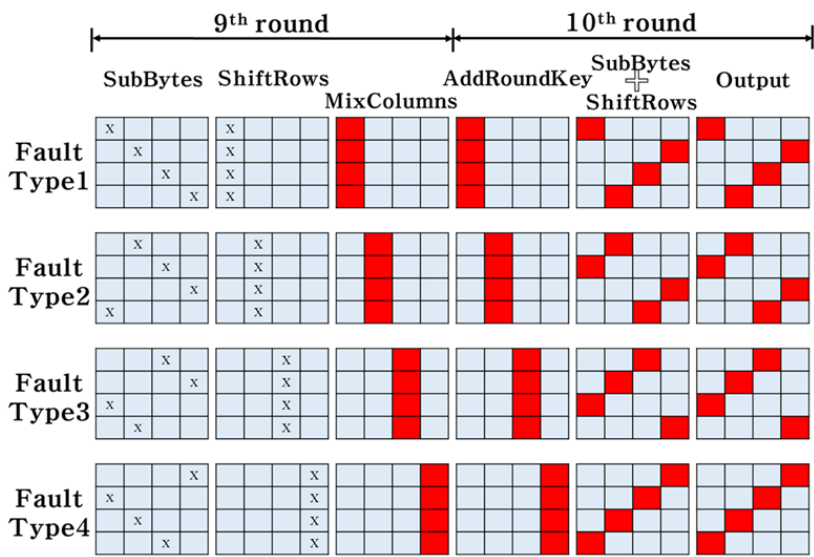
Figure 6. Propagation of a fault inserted into the input of the 9th round of AES according to the Fault